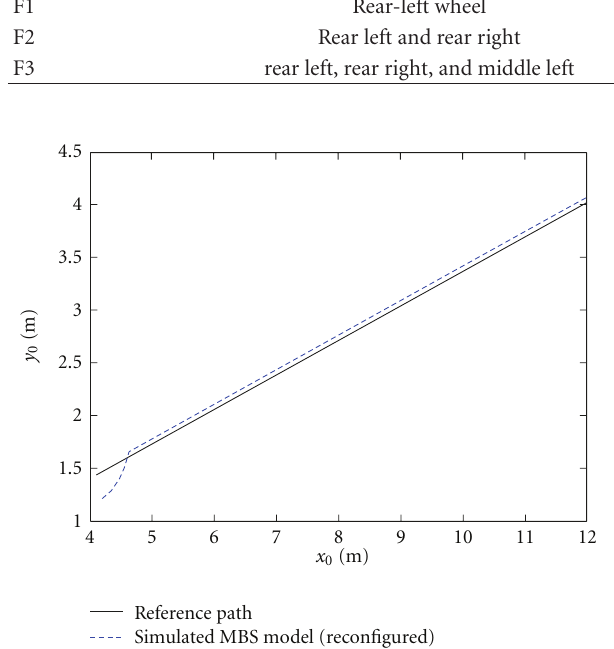
Figure 16: Fault-tolerant controller of the ExoMars rover simu-